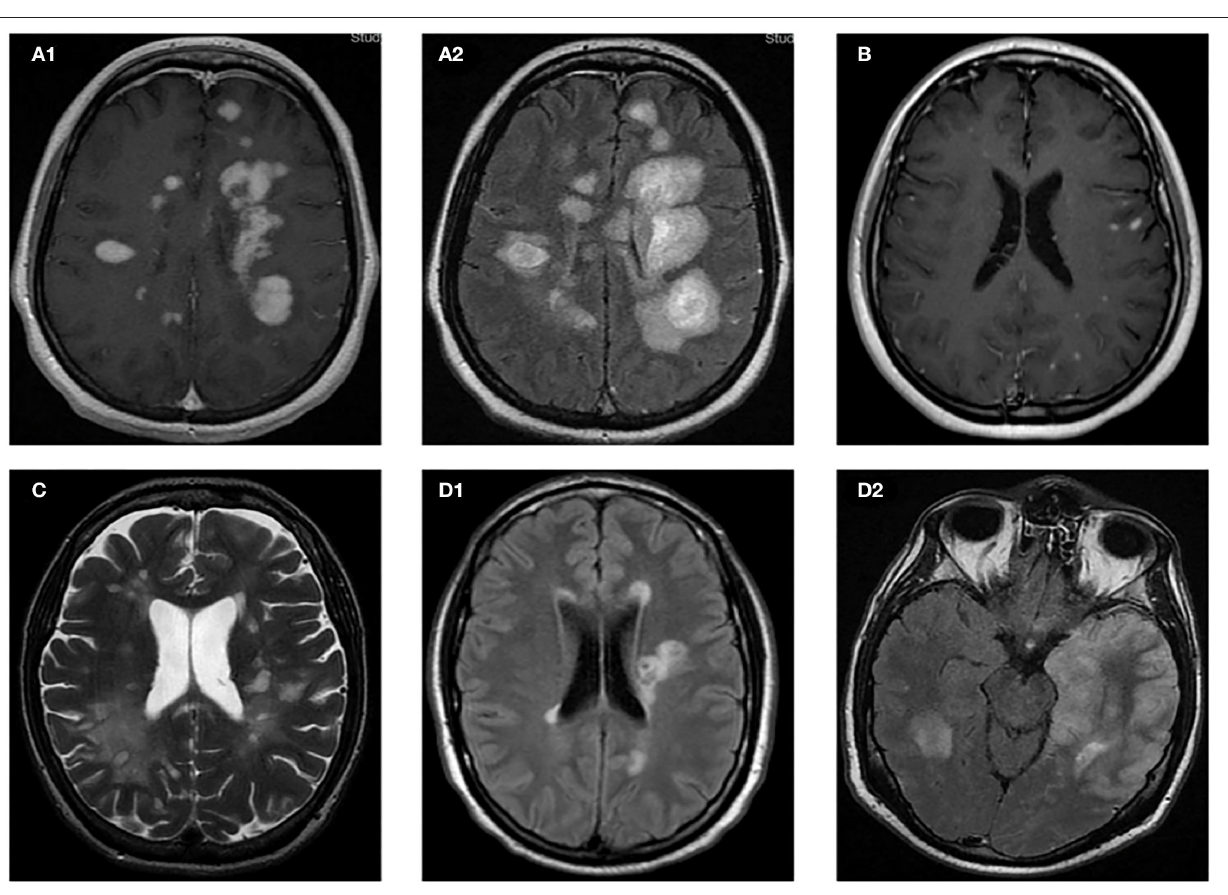
dose of 500 mg IV rituximab 24 h prior to the first